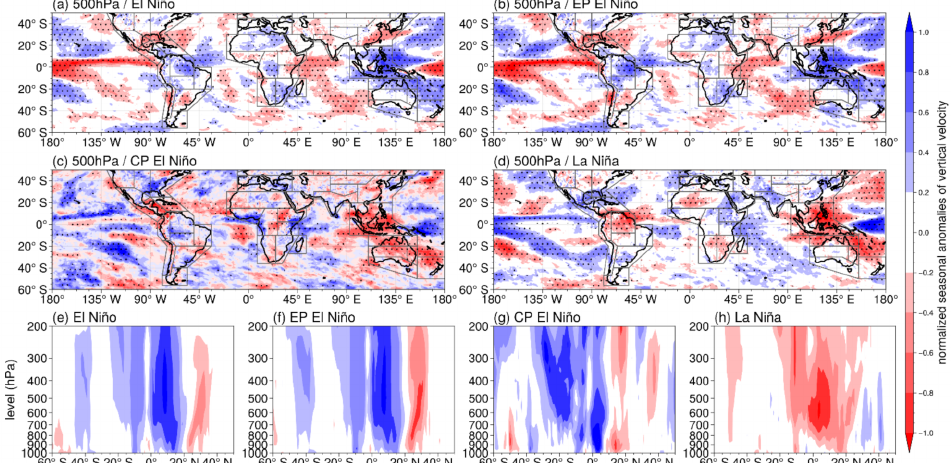
Figure 10. Normalized seasonal anomalies of vertical velocity in DJF during ( a ) El Niño, ( b ) EP El Niño, ( c ) CP El Niño and ( d ) La Niña. The red (blue) contours represent vertical descending (upward) motions. ( a – d ) show the vertical velocity anomalies at 500 hPa during these events, and the dotted areas are significant at the 95% confidence level. ( e – f ) are the average of vertical velocity anomalies between 130 ◦ –150 ◦ E.